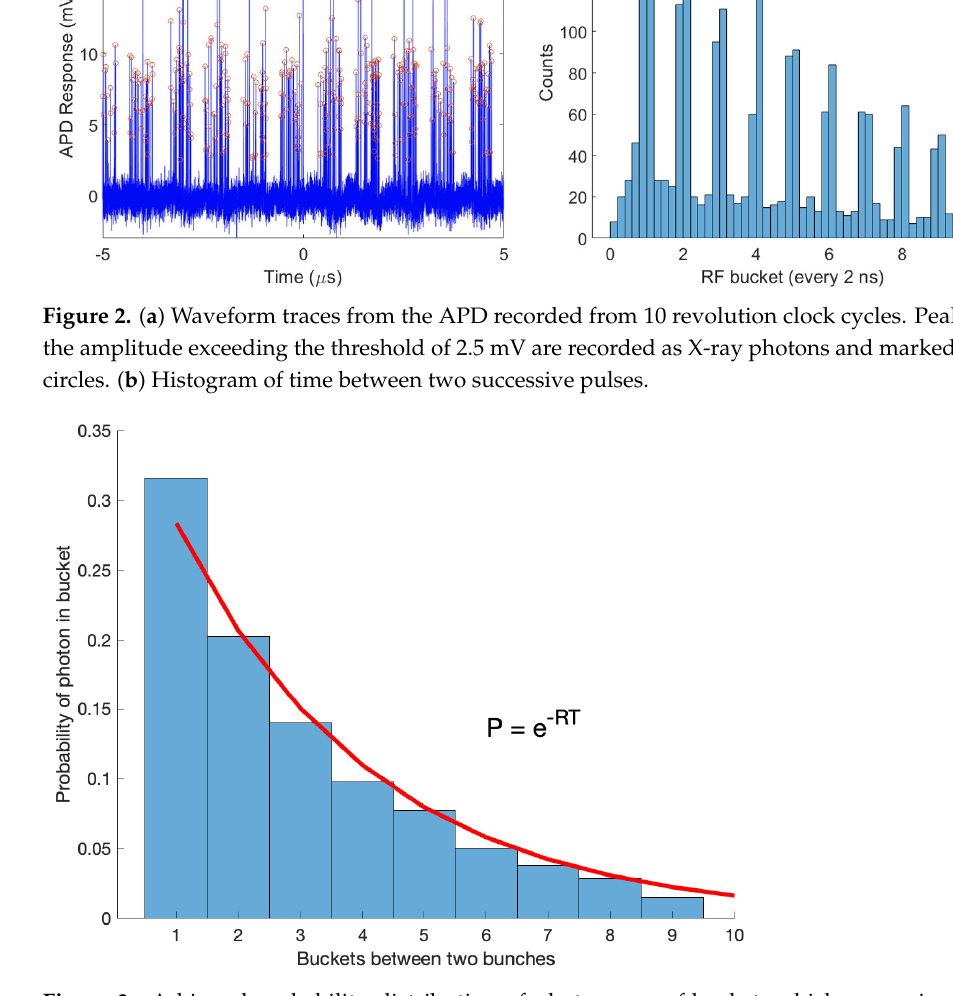
Figure 3. A binned probability distribution of photons per rf-bucket, which approximates the exponential distribution P = e − RT of a continuous random variable where R is the detected photon rate (34 MHz in this example) and T is the time between pulses, or 2